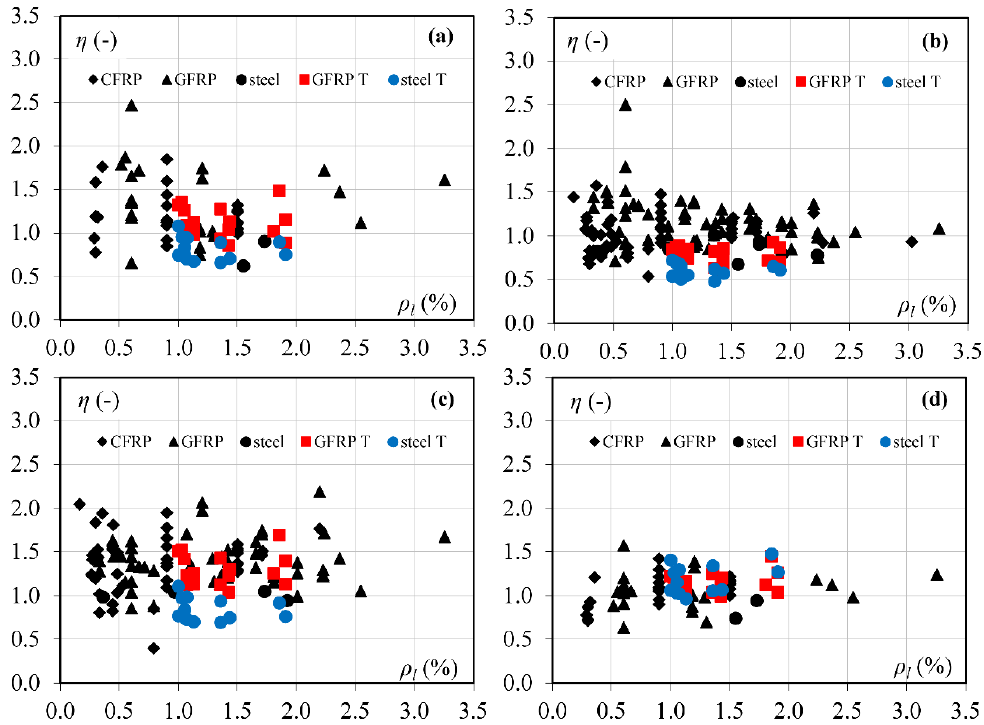
Figure 4. The influence of longitudinal reinforcement ratio on η values: ( a ) Muttoni and Ruiz [11], ( b ) Zhang et al. [12], ( c ) Yang [13], ( d ) Cladera et al. [14].